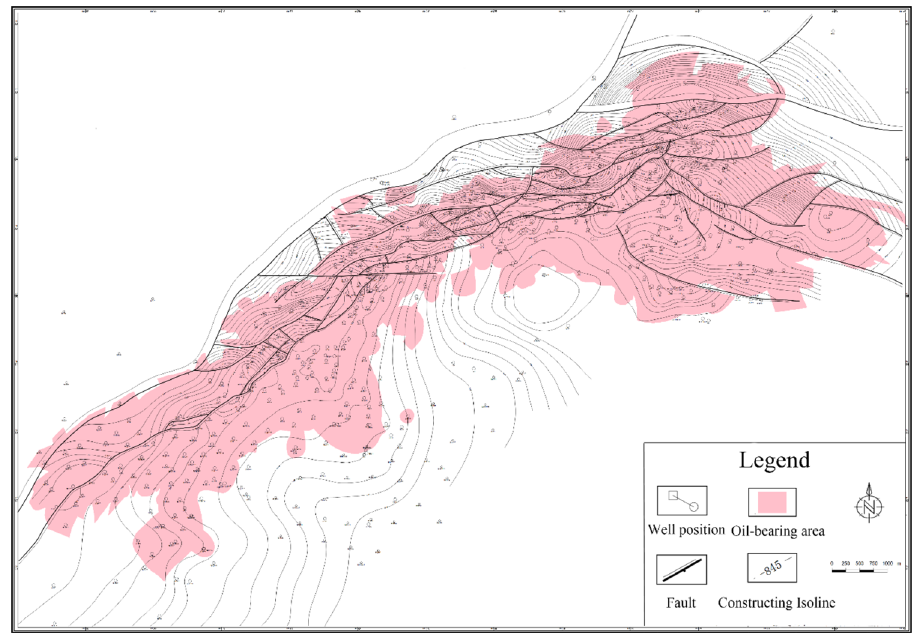
Fig. 4 Location map of